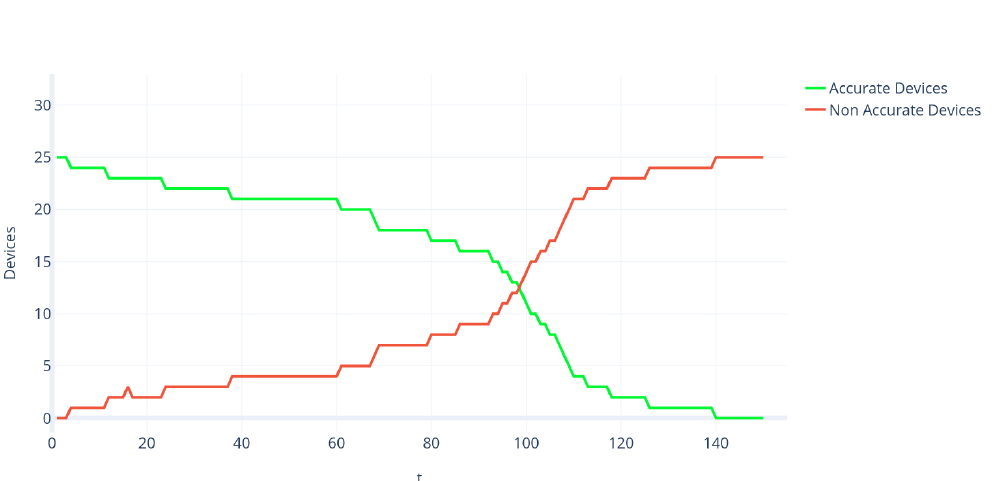
Figure 6. Time evolution of prey (accurate devices) and predator (non-accurate devices) absolute populations of simulation 1 of the Lotka Volterra Non Autonomous model proposed in this paper. The predator population (red line) grows as AD star to fail, reaching a point where no prey (AD) populates the system. In this simulation, human intervention is not taken into account; therefore,